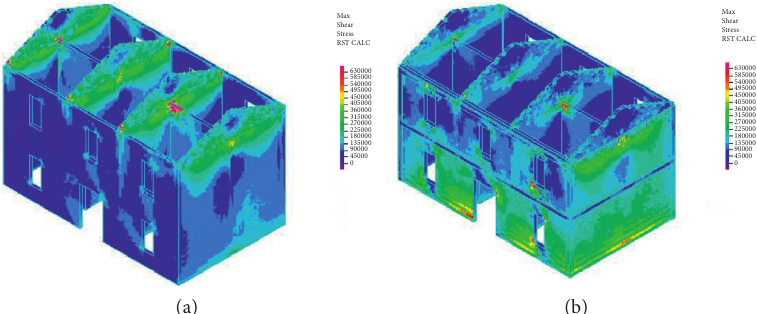
Figure 21: Comparison of shear stress of the structure before and after reinforcement. (a) Original structure. (b) Structure after reinforcement.